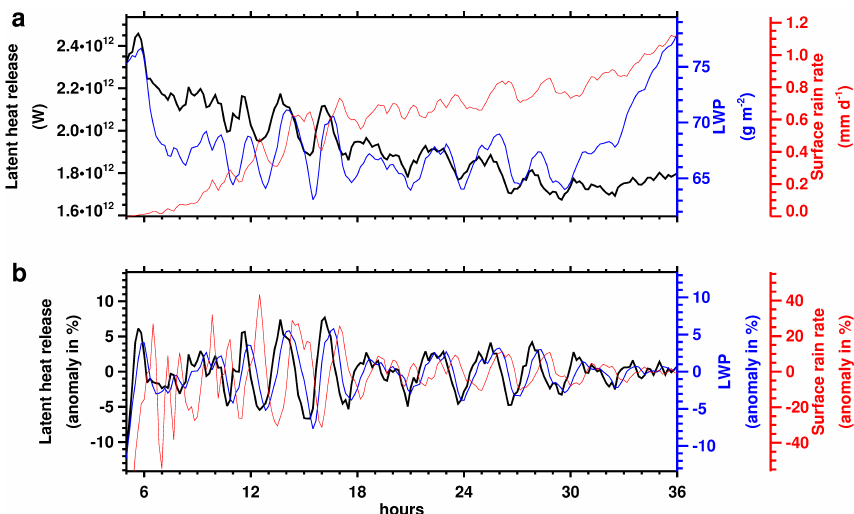
Fig. 16. (a) domain-integrated latent heat release (heating of the air from condensation of water vapor), domain-averaged liquid water path and surface rain, and (b) their temporal anomalies (against a 3h running mean) in simulation S ⊗ .